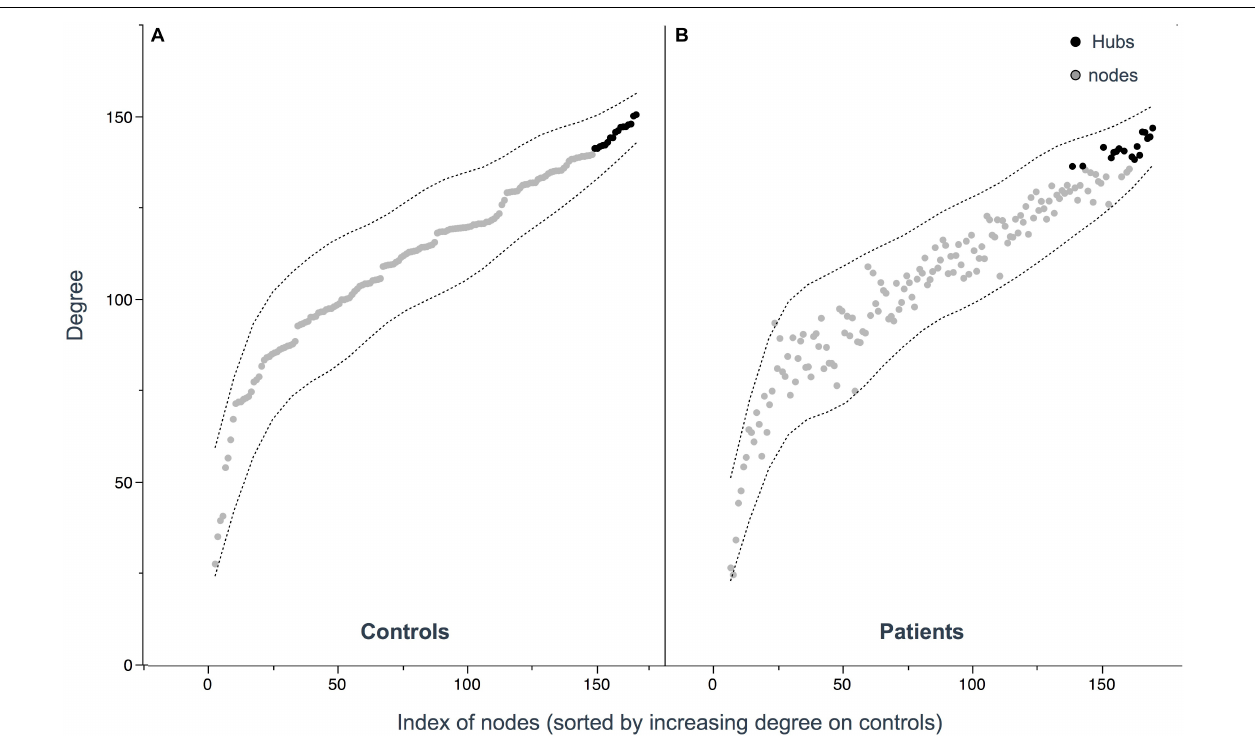
FIGURE 3 | Hub distribution patterns among controls (A) and patients (B) . Hubs were defined as nodes with a degree one standard deviation higher than the average node degree. 17 hubs were identified in patients and 17 hubs in controls. Nodes (A,B) are sorted out by increasing values of degree in controls showing similar